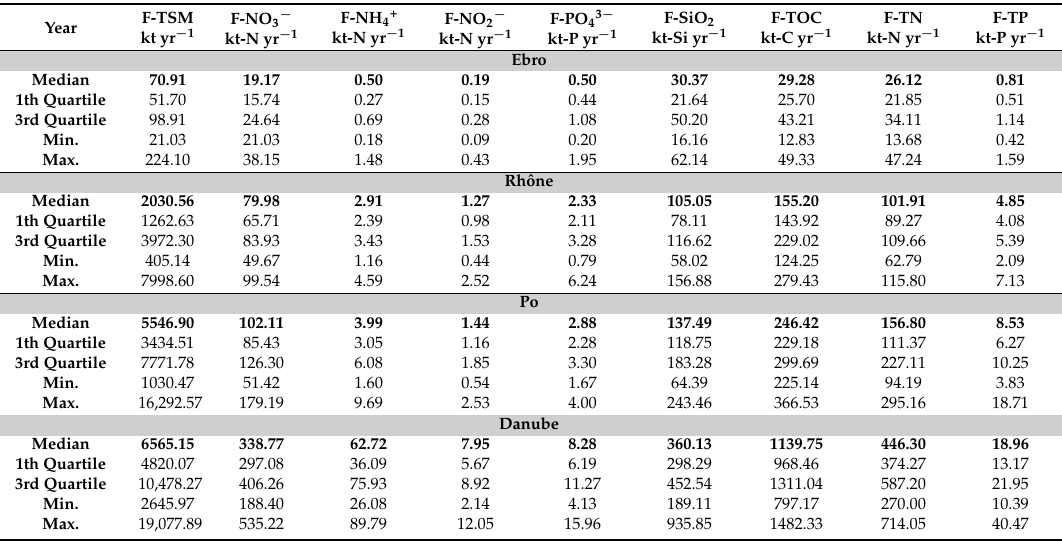
Table A3. Statistics of the dataset of annual transport (F; kt yr − 1 ) of TSM, nutrients and total nitrogen and phosphorus at the river mouths of the Ebro, Rh ô ne, Po and Danube, in